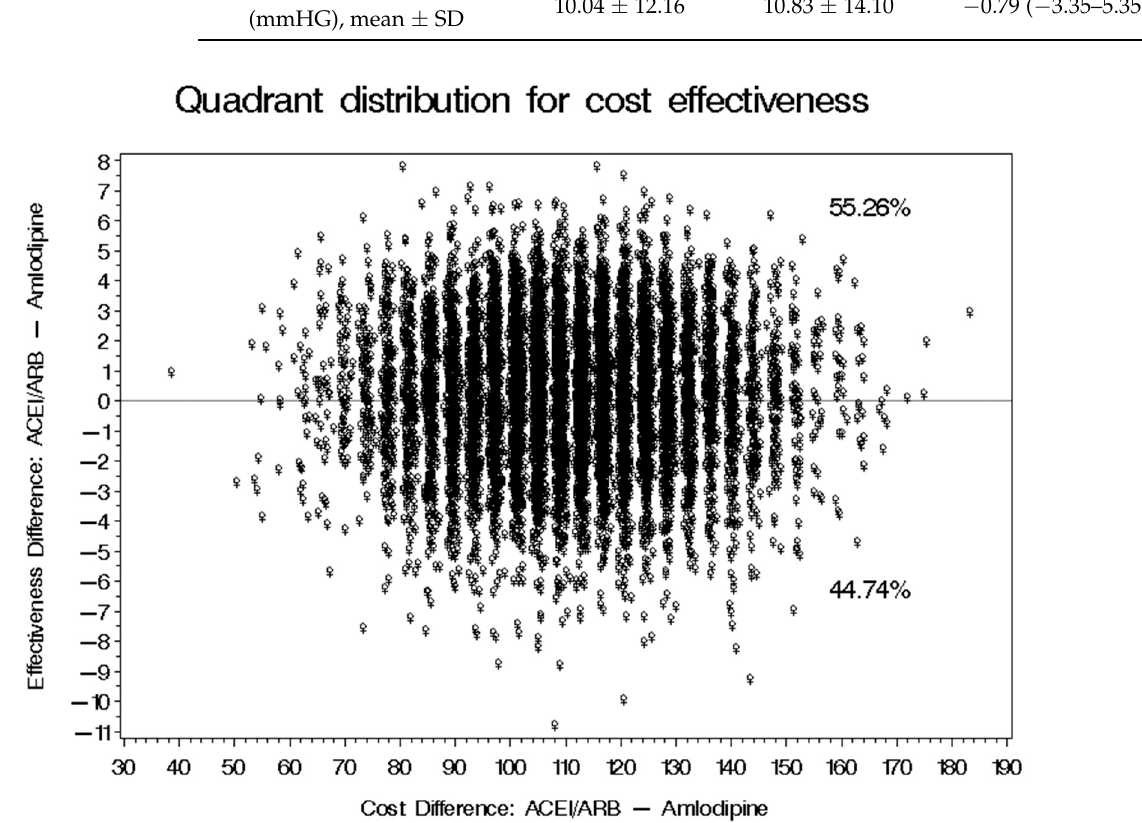
Figure 3. The probabilistic sensitivity analysis of the cost effectiveness of ACEIs/ARBs versus amoldipine in the management of high SBP.